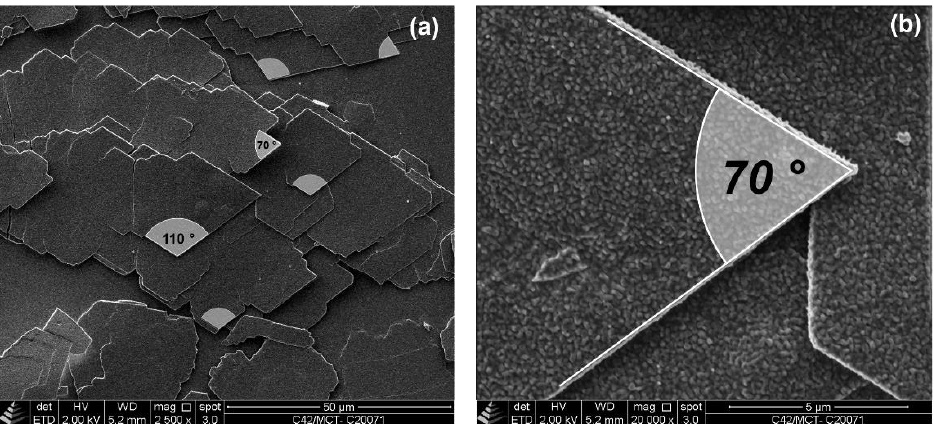
Figure 4. Scanning electron microscopy (SEM) micrographs of WE CN 42 (22_20) for a de-oiled 10% [ w / w ] oleogel sample: 2500× magnification ( a ); 20,000× magnification ( b ).